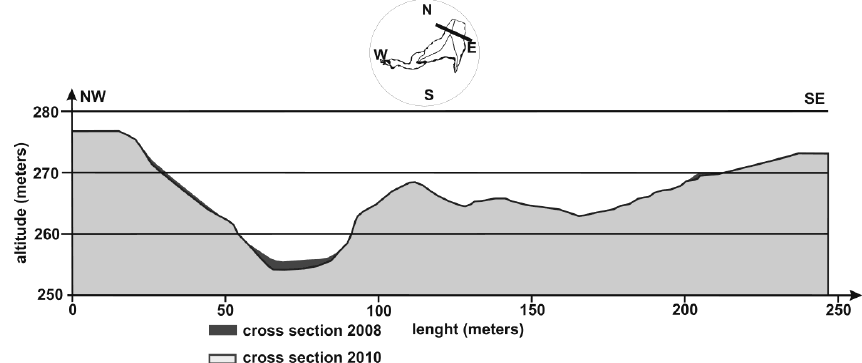
Fig. 17. Cross-section of the Cucuteni-Baiceni outlet gullies.